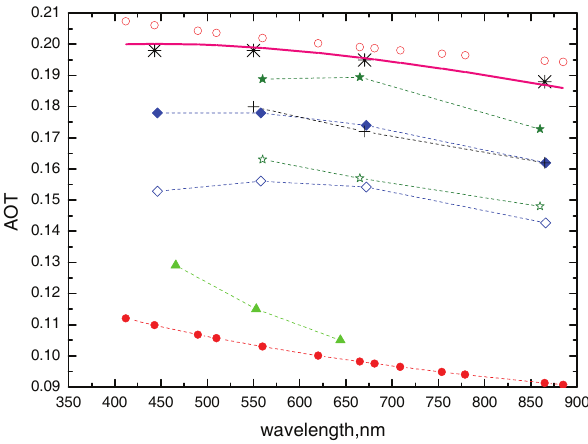
Fig. 13a. The spectral AOT according to different retrievals (the case with the reference AOT = 0.2 at 412nm). NASB-1 retrievals have been for the oceanic aerosol and NASB-2 retrievals have been done for the water soluble aerosol (WCP-112, 1986; Kokhanovsky, 2008). The legend is the same as in Fig. 11 and the true spectral AOT is given by the pink line.